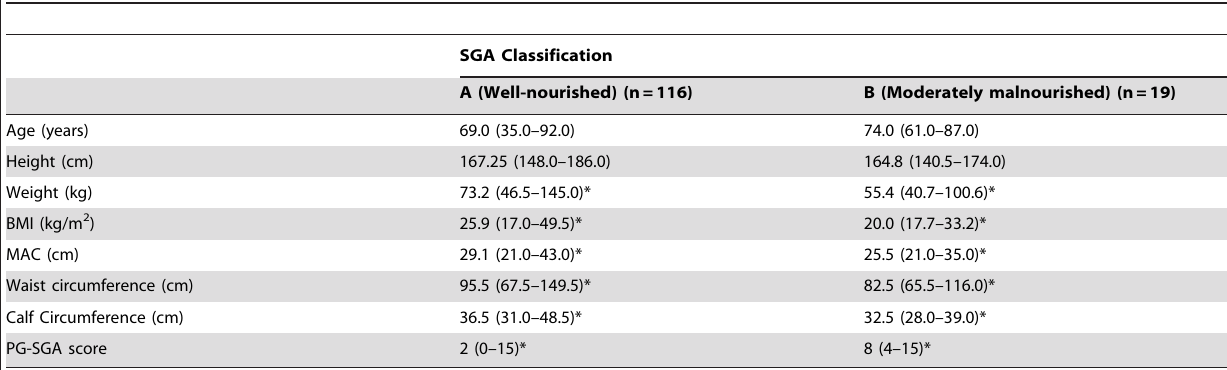
Table 1. Characteristics of the participants compared between nutritional status categories using Mann-Whitney analysis for continuous variables and Chi square analysis for categorical variables and reported as median (range).